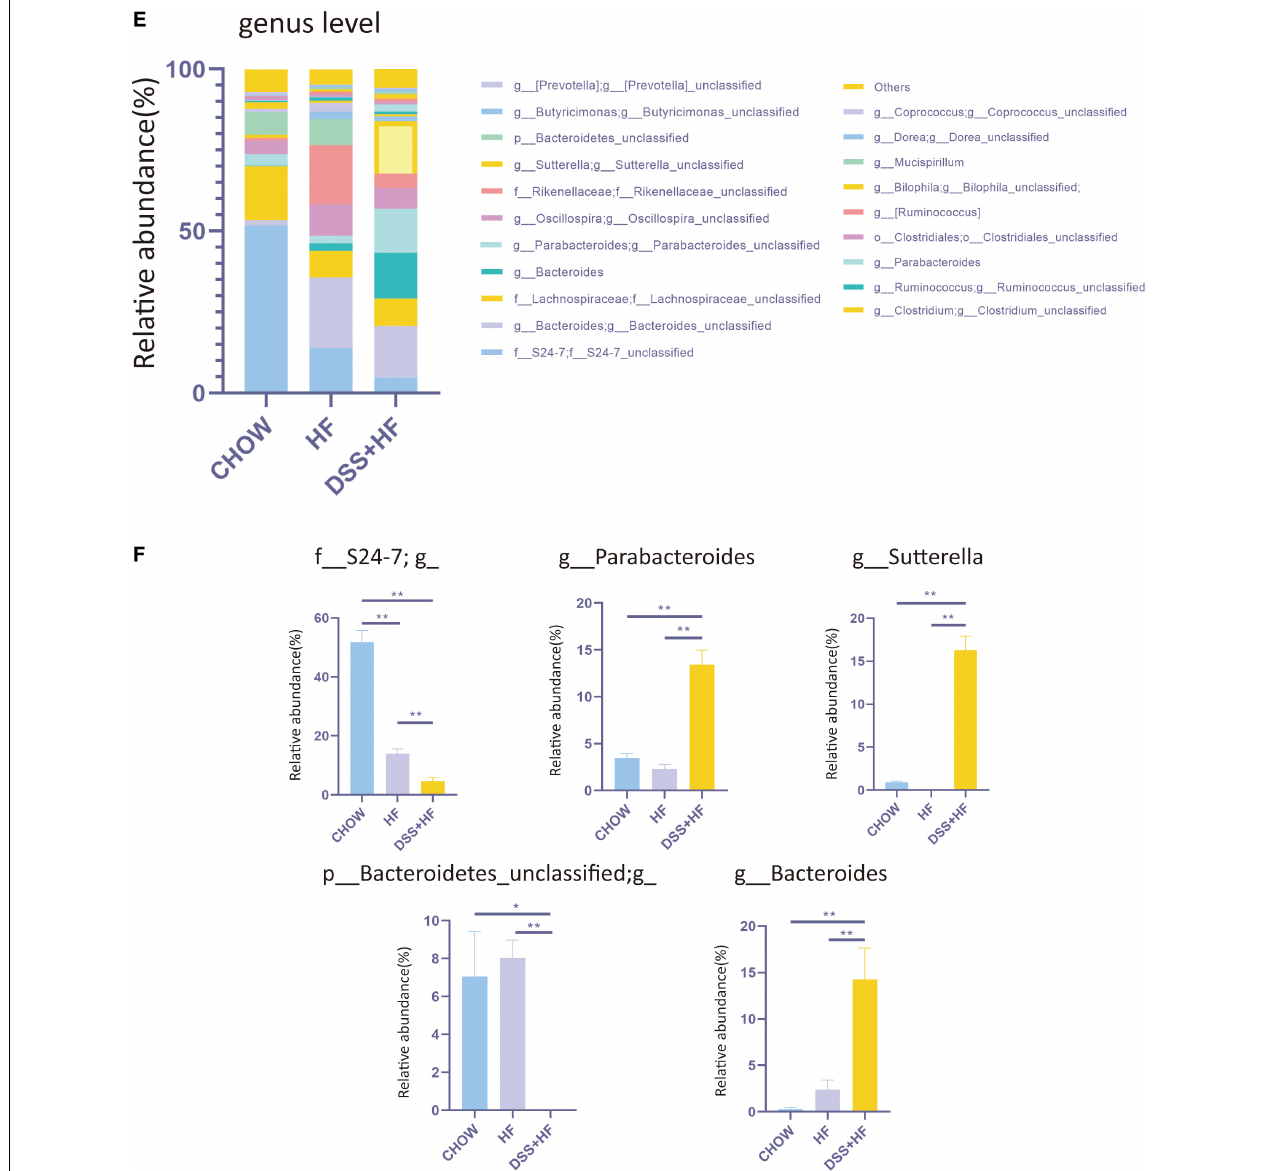
FIGURE 3 | Community structure of gut microbiota shows distinct changes after DSS treatments. (A) The abundance of microbiota (Ace index of OTU) and the diversity of microbiota (Shannon index of OTU) in chow, HF, and DSS + HF group. The data are expressed as the mean ± SEM. * P < 0.05; ** P 0.01. (B) Bray–Curtis distance-based principal coordinate analysis (PCOA) for chow, HF, and DSS (+ HF group (9 per/group). (C) The phylum levels of microbiota in the above groups. (D) The representative phylum level distribution of microbiota in the above groups (9 per/group). The data are expressed as the mean ± SEM. The statistical analyses were done with Wilcoxon rank-sum test. NS, not statistically significant; * P < 0.05; ** P < 0.01. (E) The genus levels of microbiota in the above groups. (F) The representative genus level distribution of microbiota in the above groups (9 per/group). The data are expressed as the mean ± SEM. The statistical analyses were done with Wilcoxon rank-sum test. * P < 0.05; ** P <